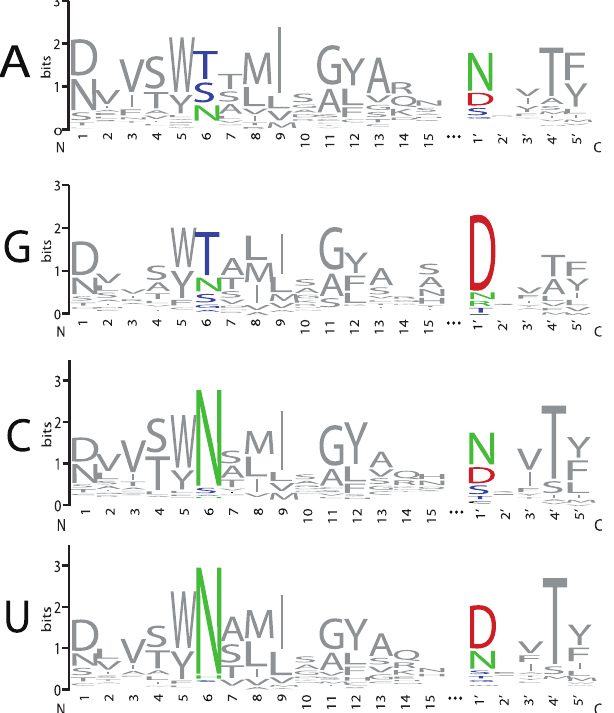
Figure 3. Amino Acid Representation at Each Position of PPR Motifs that Align with A, G, C, or U Bases. Motif pairs from PPR10, HCF152, CRP1 and 37 RNA editing factors flanking the indicated nucleotide were used to construct sequence logos [30]. Each logo shows the first fifteen positions of the P-type motif containing position 6, a gap, and then the first 5 positions of the following motif. 74, 48, 96 and 126 motif pairs were used to generate the A, G, C and U logos, respectively. The alignments used to generate the logos are shown in Figure S1.